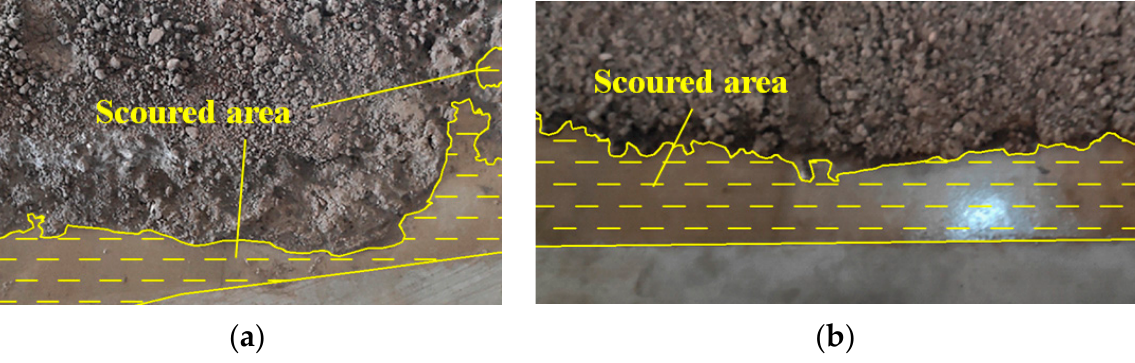
Figure 6. Soil erosion in the bare soil: ( a ) soil erosion at the inlet of the test section (RUN 3, after 18 h scouring); ( b ) soil erosion near the slope foot (RUN 4, after 29 h scouring).